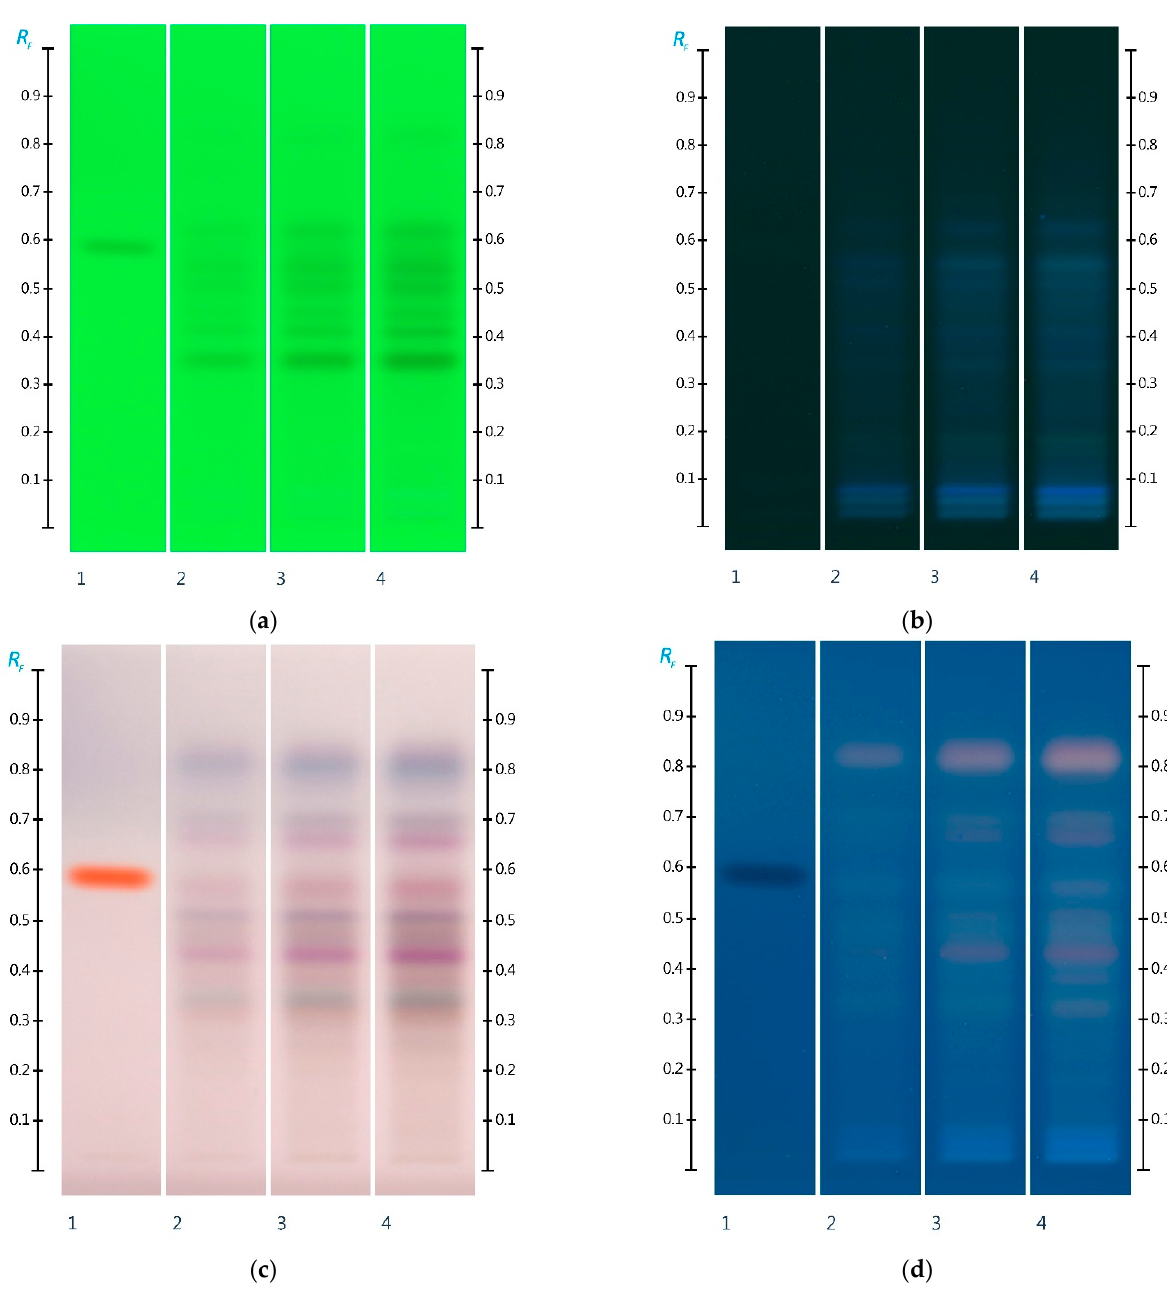
Figure 5. HPTLC images taken at ( a ) 254 nm, ( b ) 366 nm, ( c ) white light, and ( d ) 366 nm after deri- vatization with vanillin reagent; Track 1—4,5,7-trihydroxyflavanon, Track 2—5 µL, Track 3—10 µL, and Track 4—15 µL ant honey extract. Track 4—15 µ L ant honey